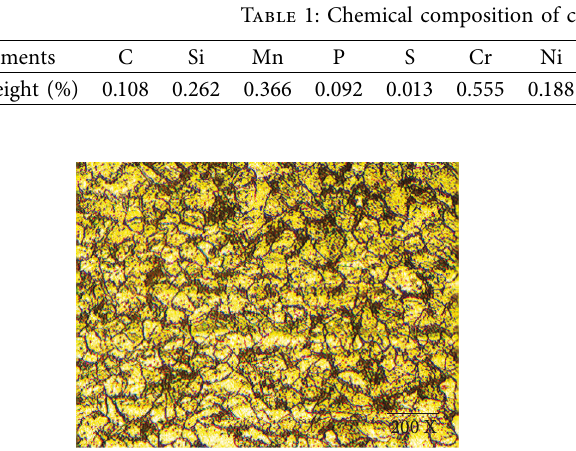
Figure 1: Microstructure of corten steel.